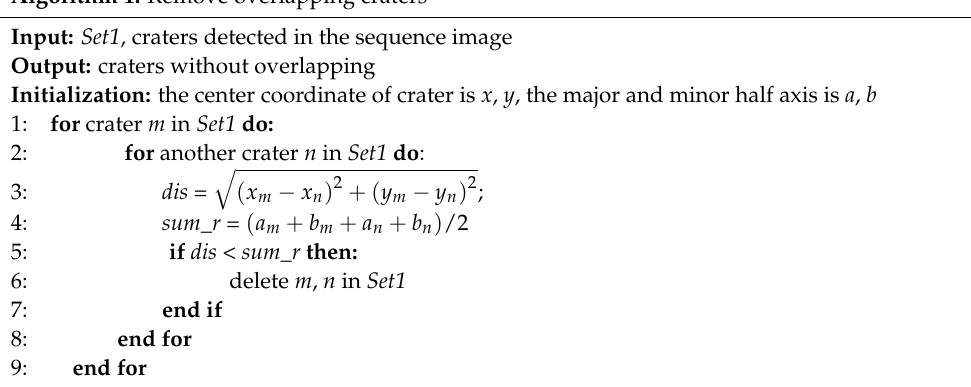
Algorithm 1. Remove overlapping